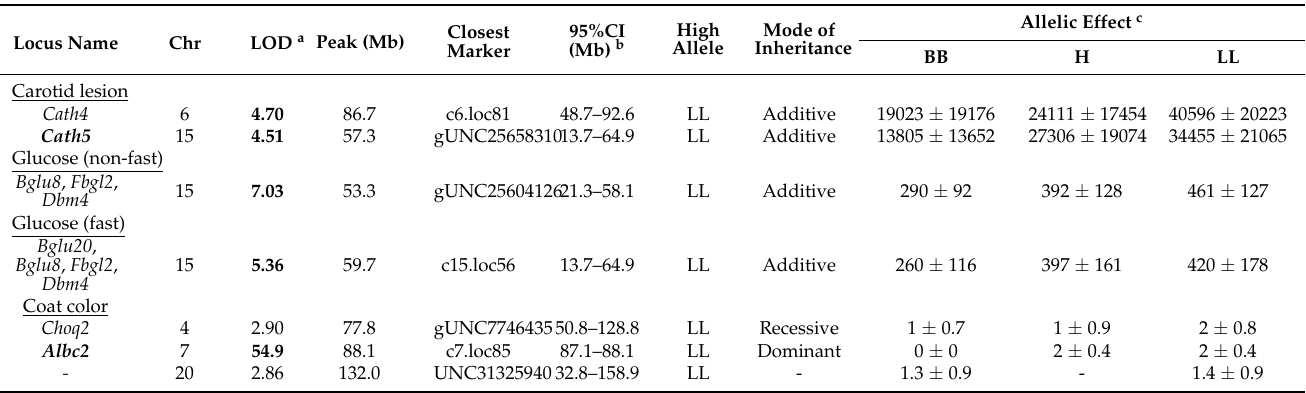
Table 1. Significant and suggestive QT for carotid atherosclerosis, plasma glucose, body weight, and coat color mapped with male F2 mice derived from LP- and BALB- Apoe − / −